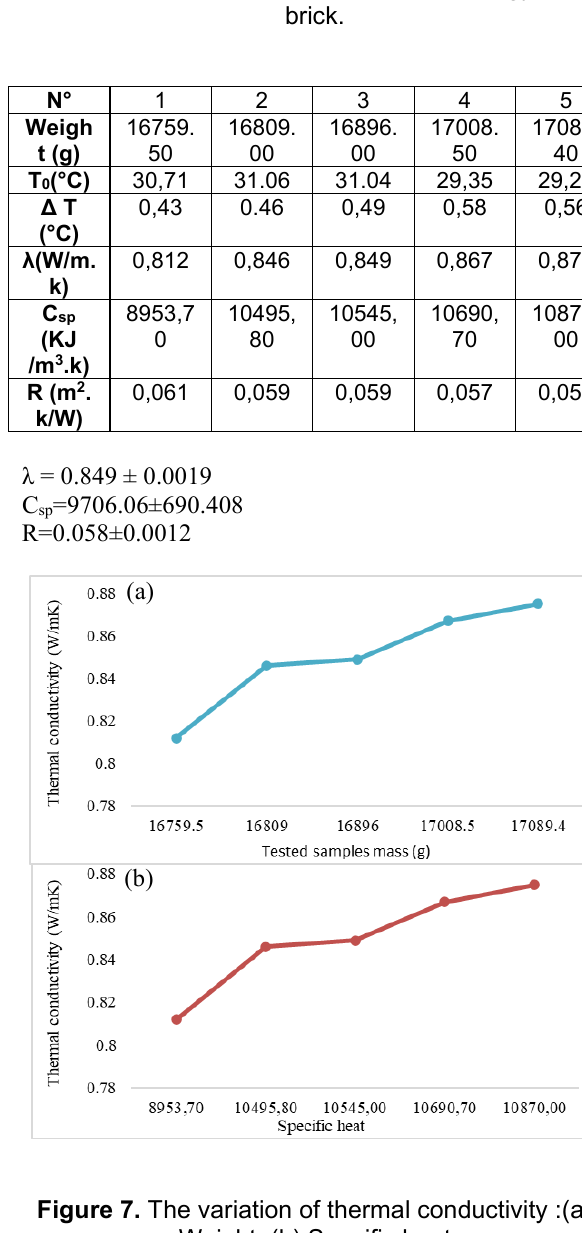
Figure 7. The variation of thermal conductivity :(a) Weight; (b) Specific heat From the figure 7.a, it is noted that there is a direct correlation between the thermal conductivity and the mass of the tested building blocks (the volume mass is proportional to the thermal conductivity) of the tested samples the same size. Also, in Figure 7.b, there is a direct correlation between the specific heat and the thermal conductivity where the higher the specific temperature, the greater the thermal